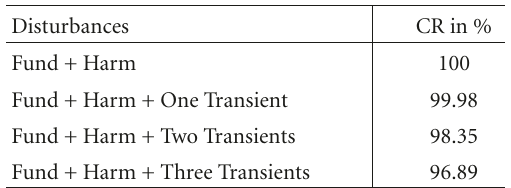
Table 4: Performance of the proposed technique for the classifica- tion of multiple disturbances in vector x